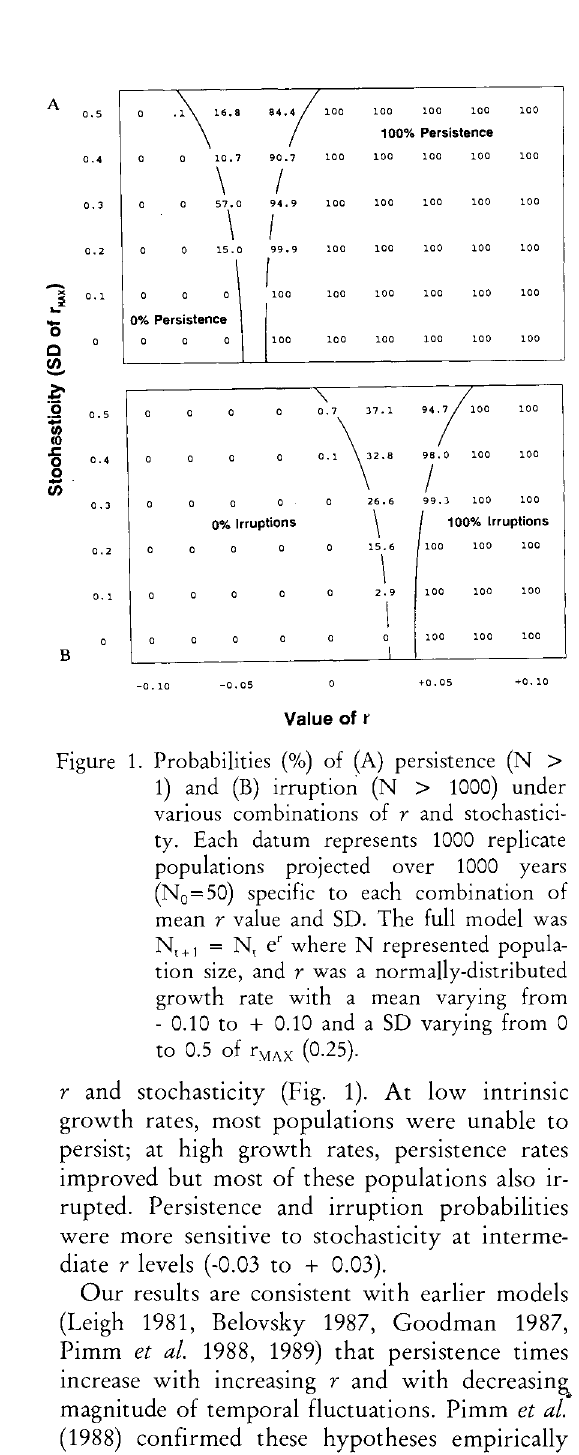
Figure 2. Hypothesised non-linear relationship be tween r and snow cover for Model 2. Snow cover values were normally distribu ted, with a mean of 1 and SD of